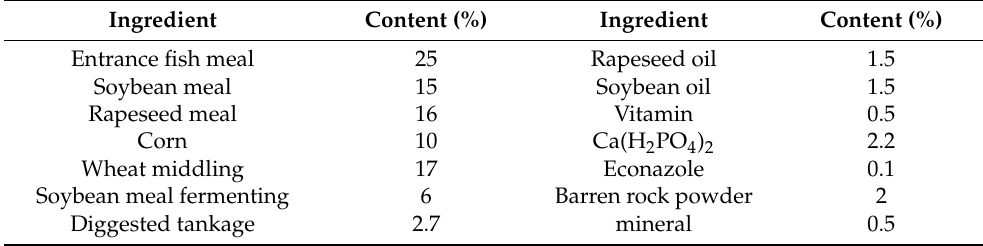
Table 1. Ingredient composition of the basal diet in cultured fish.